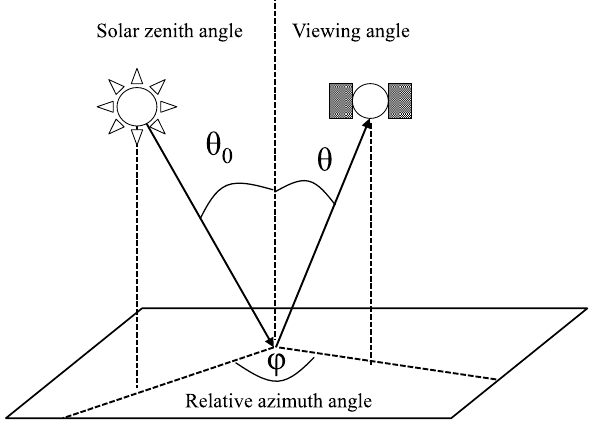
Figure 1. Definition of geometry angles of Fig. 1. Definition of geometry angles of BRDF.